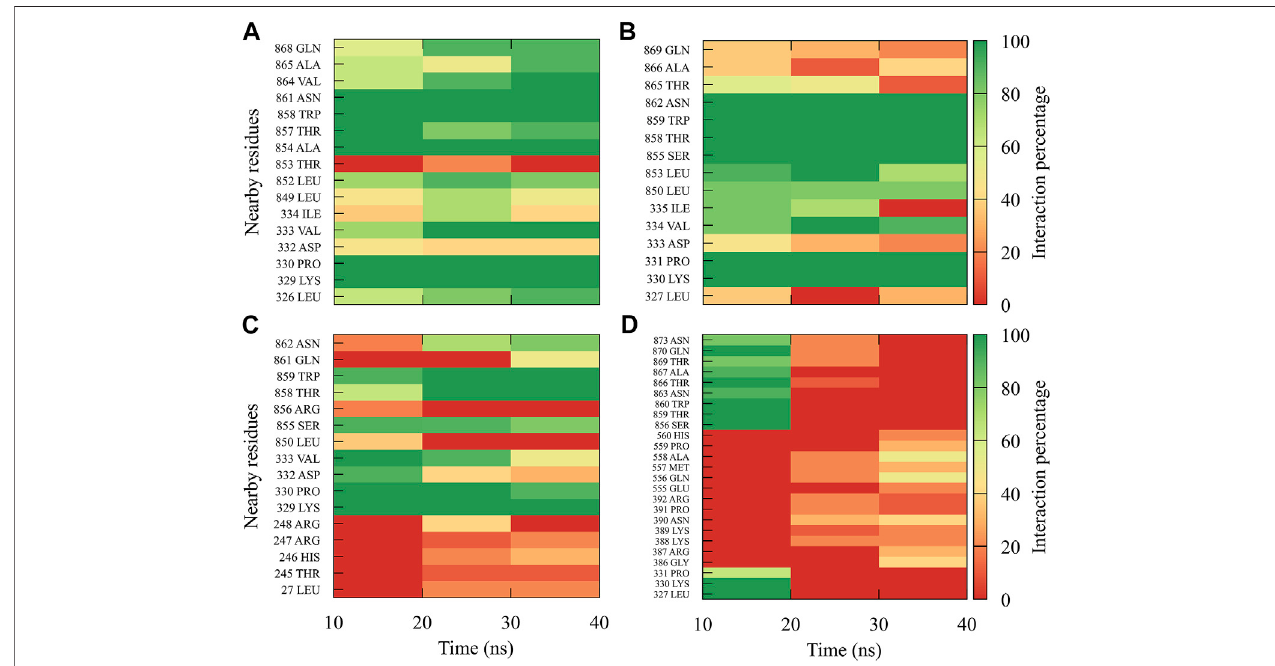
FIGURE8| Contactfrequencymapsforthecompound 4md , boundtothecavityBofthe (A) DENV1, (B) DENV2, (C) DENV3,and (D) DENV4.Redrepresentsthat the contact frequency was 0%, while green represents that the contact frequency was 100%.